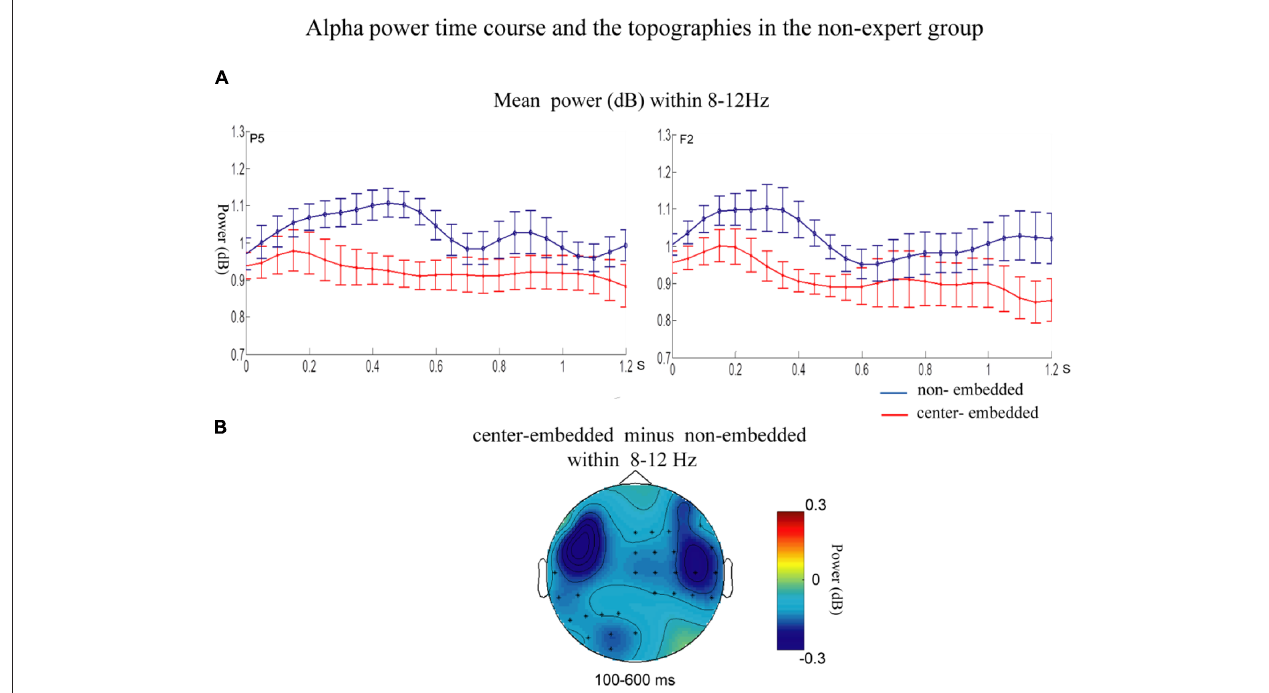
FIGURE 4 | Time course of the mean alpha power and difference topographies of final chords in the non-expert group. (A) Temporal course of the mean alpha power (8–12 Hz) between 0 and 1200 ms after the onset of the final chords for the non-embedded and center-embedded conditions at electrodes P5 and F2. Error bars indicate standard errors. (B) The difference topographies (center-embedded minus embedded) in the alpha band (8–12 Hz) within the 100–600 ms. The electrodes that showed significant effects over 30% of the selected time intervals were marked by